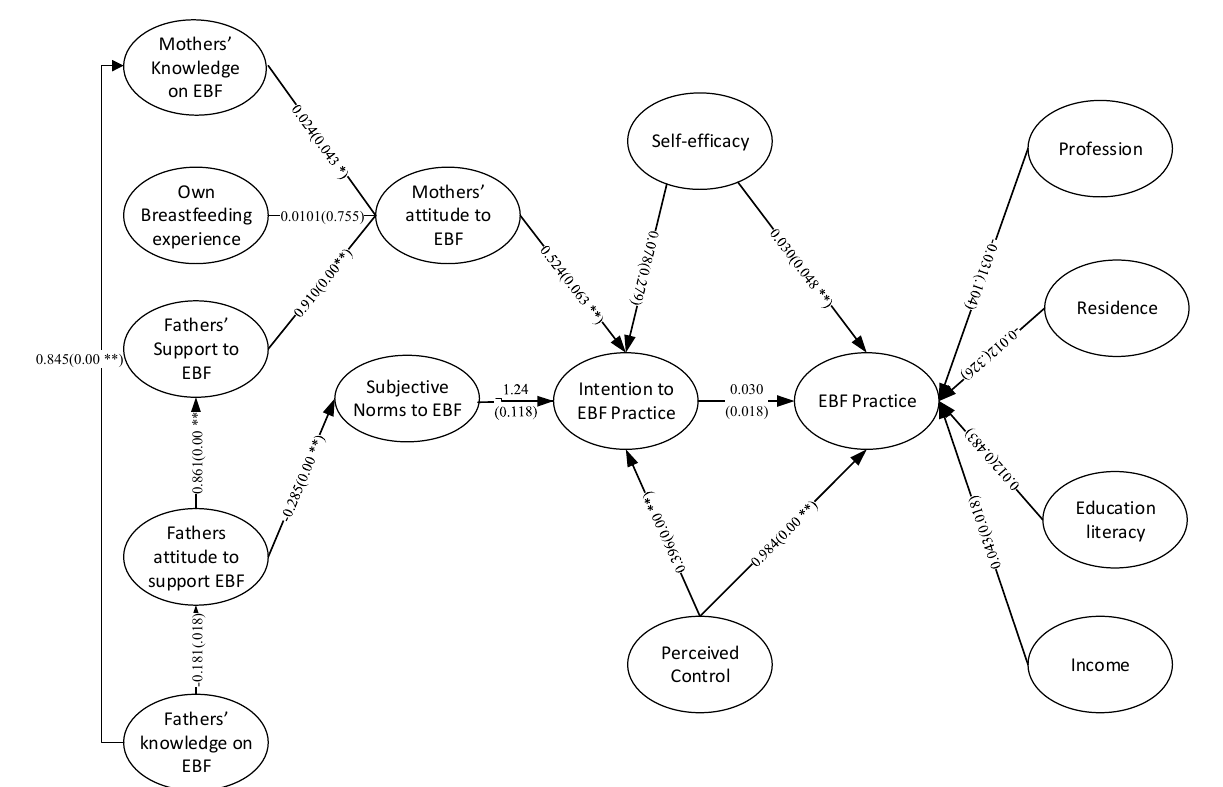
Figure 4. Multi group analyzing the role of father’s knowledge and attitude on mother’s breastfeeding (BF) knowledge, attitude and practice in Bangladesh (on vaginal delivery subsample). * Significant at p < 0.05; ** Significant at p < 0.01.